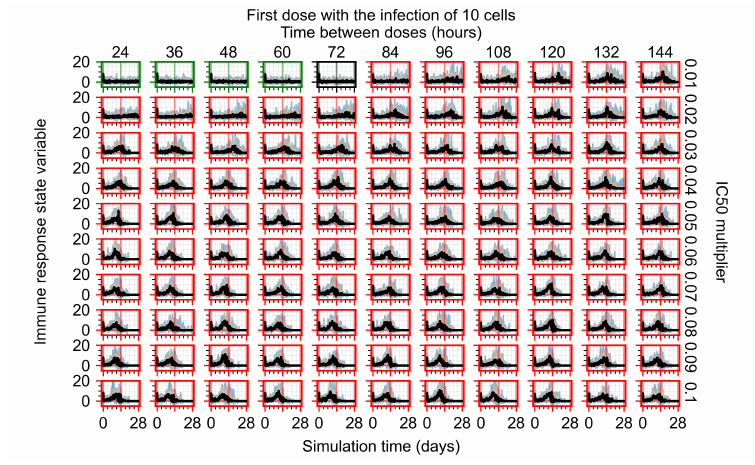
Figure A74. Immune response state variable number. Positive values correspond to an inflammatory state, and negative to an anti-inflammatory state.